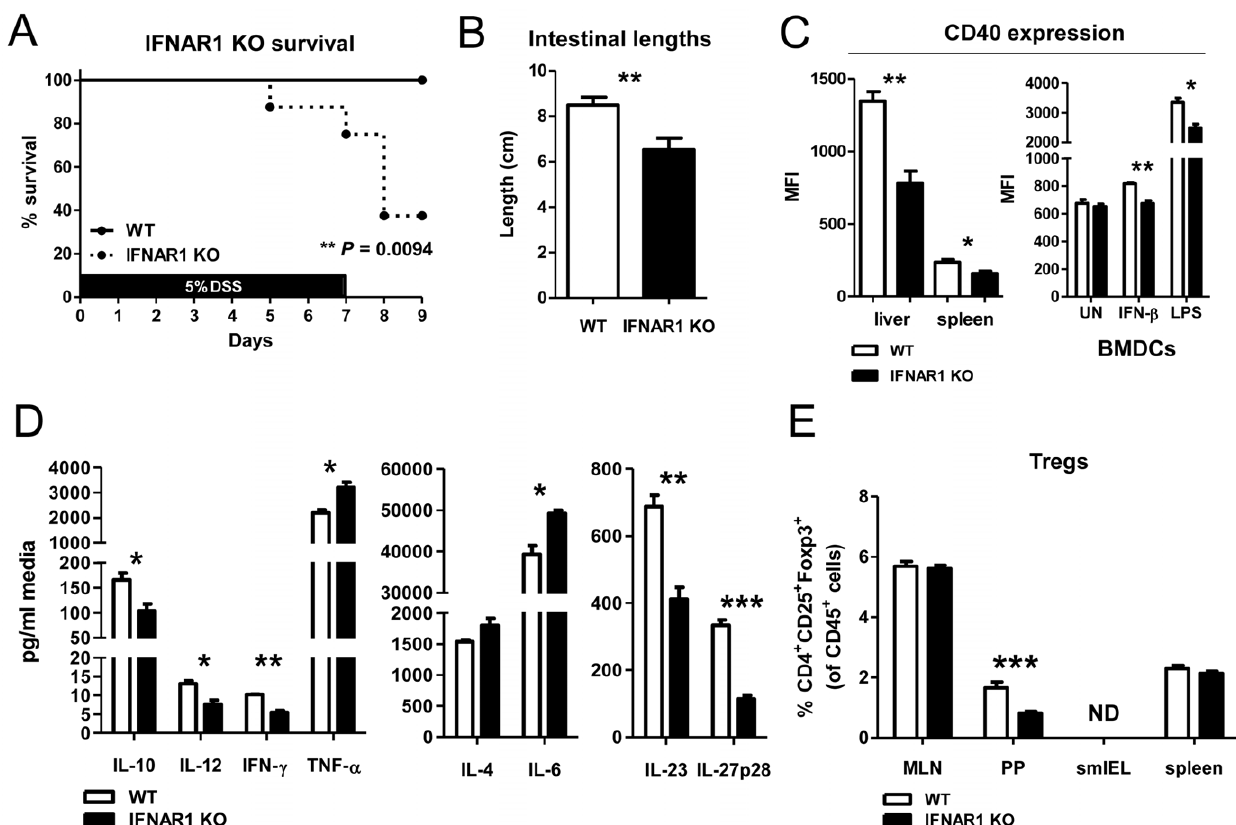
Figure 1. IFNAR1 2 / 2 mice are more susceptible to DSS-induced colitis and have altered DC and Treg profiles. ( A, B ) IFNAR1 2 / 2 mice experienced increased weight loss and greater degree of intestinal shortening when administered 5% DSS in their drinking water for 7 d compared to wild-type controls (n=10). ( C ) DCs isolated from liver and spleen of IFNAR1 2 / 2 mice and BMDCs matured with IFN- b (1000 U/ml) or LPS (100 ng/ml) for 24 h were analyzed for cell surface expression of CD40. DCs were gated as CD45 + ClassII + CD11c + . ( D ) Levels of cytokines, measured by CBA or ELISA (IL-23 and IL-27p28), in BMDC supernatants stimulated with LPS (100 ng/ml) for 24 h from IFNAR1 2 / 2 or wild-type mice (n=5). ( E ) Percent Tregs, gated as CD45 + CD4 + CD25 + Foxp3 + , in MLNs, PPs, smIELs and spleens of IFNAR1 2 / 2 and wild-type mice (ND=not detected, n=10). The data is represented as the mean 6 SEM. * p , 0.05, ** p , 0.01, *** p , 0.001.